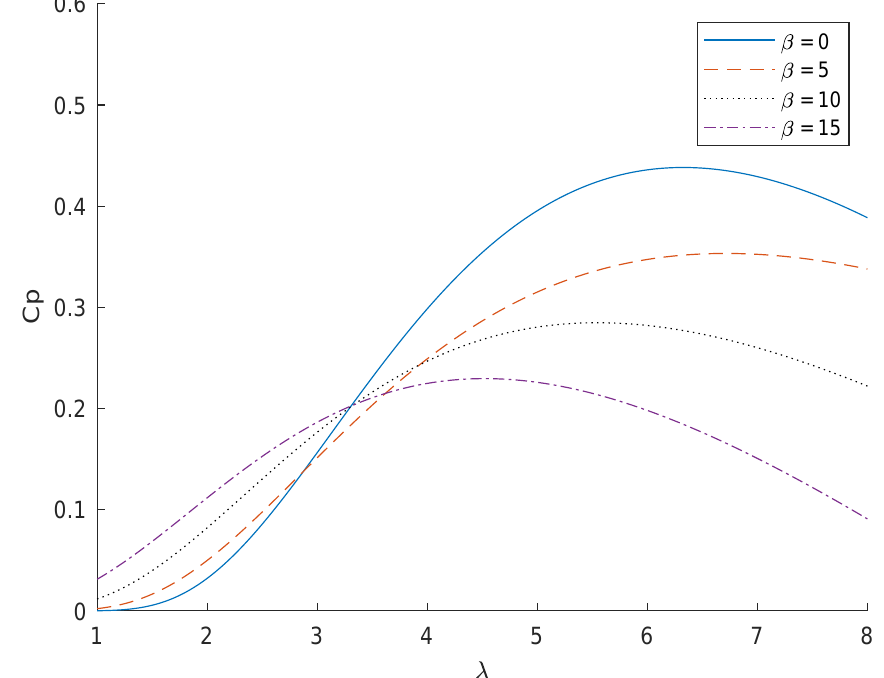
Figure 3. Aerodynamic characteristics of floating offshore wind